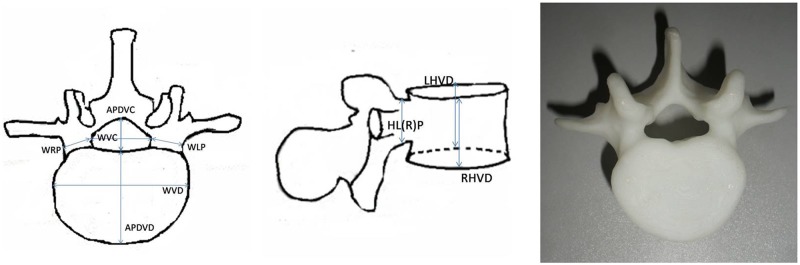
Schematic diagram showing the method for measurement ofC3-L5.
WVD is the abbreviation of Width of vertebral body; APDVD is Anteroposterior diameter of vertebral body; LHVD is Left height of vertebral body; RHVD is Right height of vertebral body; WVC is Width of vertebral canal; APDVC is Anteroposterior diameter of vertebral canal; WRP is Width of right pedicle; HRP is Height of right pedicle; WLP is Width of left pedicle; HLP is Height of left pedicle.